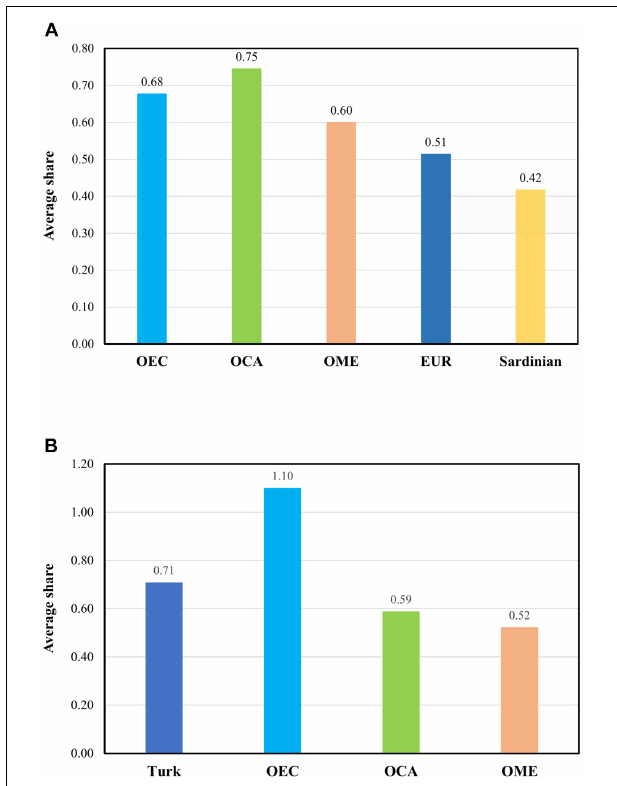
FIGURE 4 | Population relationships based on average IBD sharing estimations. We computed the genome-wide pairwise average shared IBD length between certain groups. OEC – Formerly Ottoman-occupied East Central Europe, OCA – Formerly Ottoman-occupied Caucasus region, OME – Formerly Ottoman-occupied Middle East, EUR – Europe free from Ottoman conquest. (A) Average shared IBD length between Turks and the formerly Ottoman occupied groups, Europeans not affected by the Ottoman Empire displayed separately the Sardinians. (B) Average shared IBD length between Roma and Turks and formerly Ottoman occupied populations. A more detailed table of the average IBD sharing data are available in Supplementary Table 4